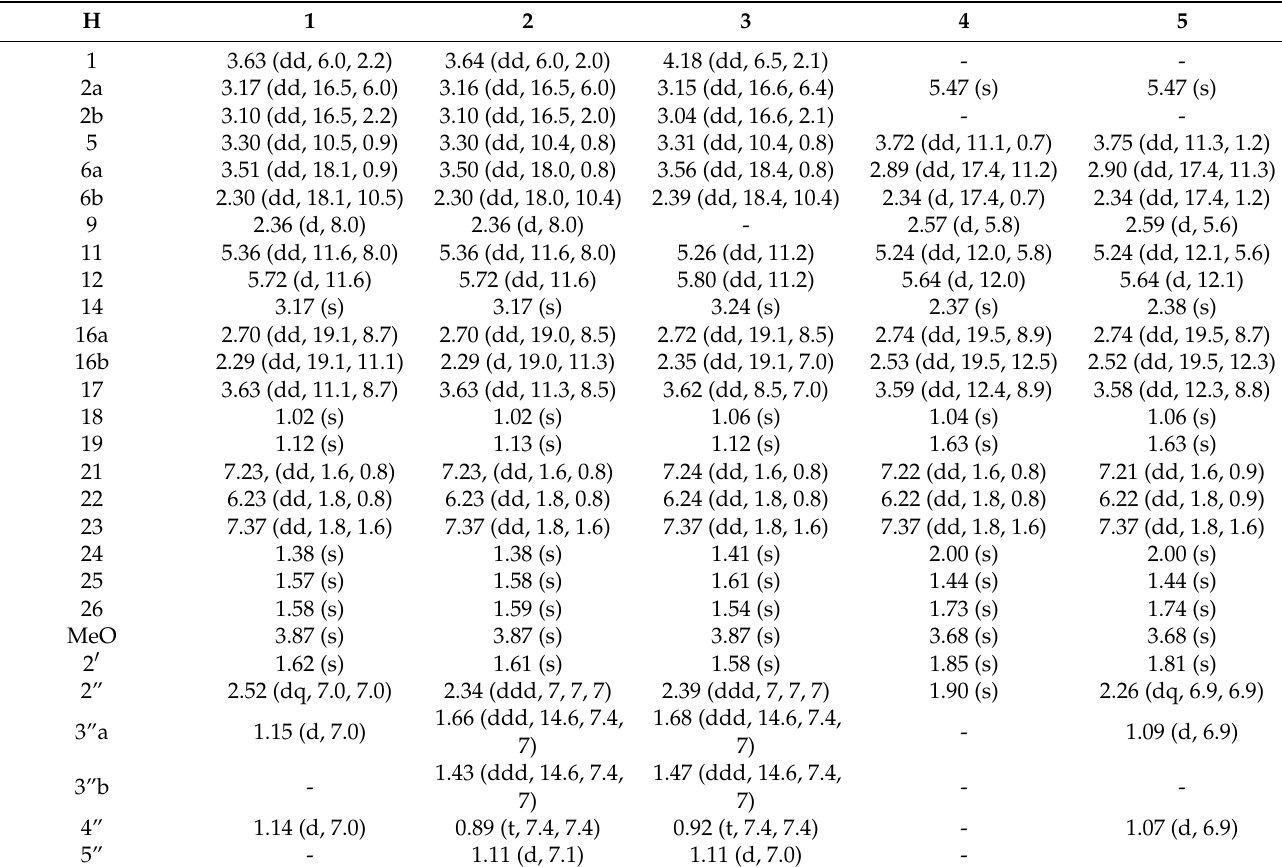
Table 1. 1 H NMR spectroscopic data for 1–5 recorded in CDCl 3 . The chemical shifts are in ppm, multiplicities and coupling constants (in Hz) are given in parentheses. The solvent signal at 7.27 ppm was used as reference.